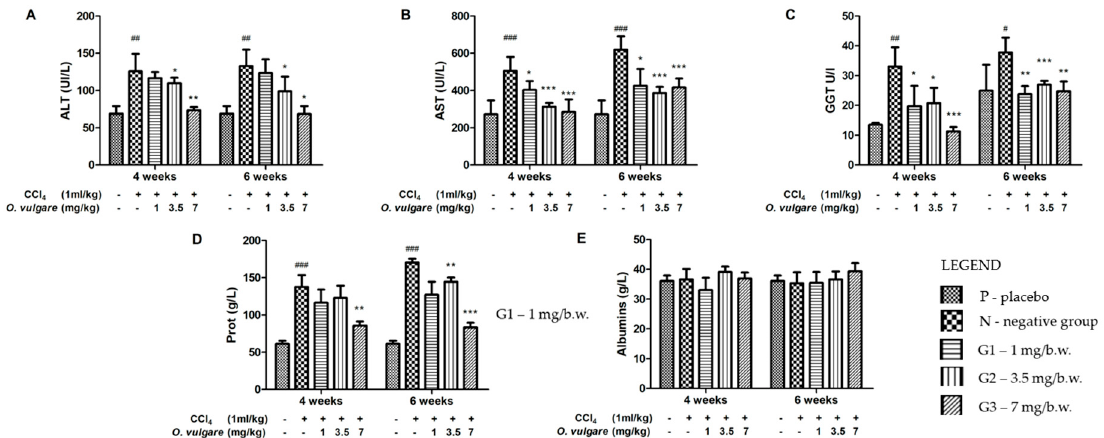
Figure 2. Effects of O. vulgare ssp. vulgare extract on: ALT ( A ); AST ( B ); GGT ( C ) activity and plasma total protein ( D ); and albumin ( E ) concentration (mean ± SD, 5 animals/group). “+” is the group which received CCl 4 and “-“ is the group which didn’t received CCl 4 . # p < 0.05, ## p < 0.01, and ### p < 0.001 compared to the reference group; * p < 0.05, ** p < 0.01, and *** p < 0.001 compared to the CCl 4 alone treated group.